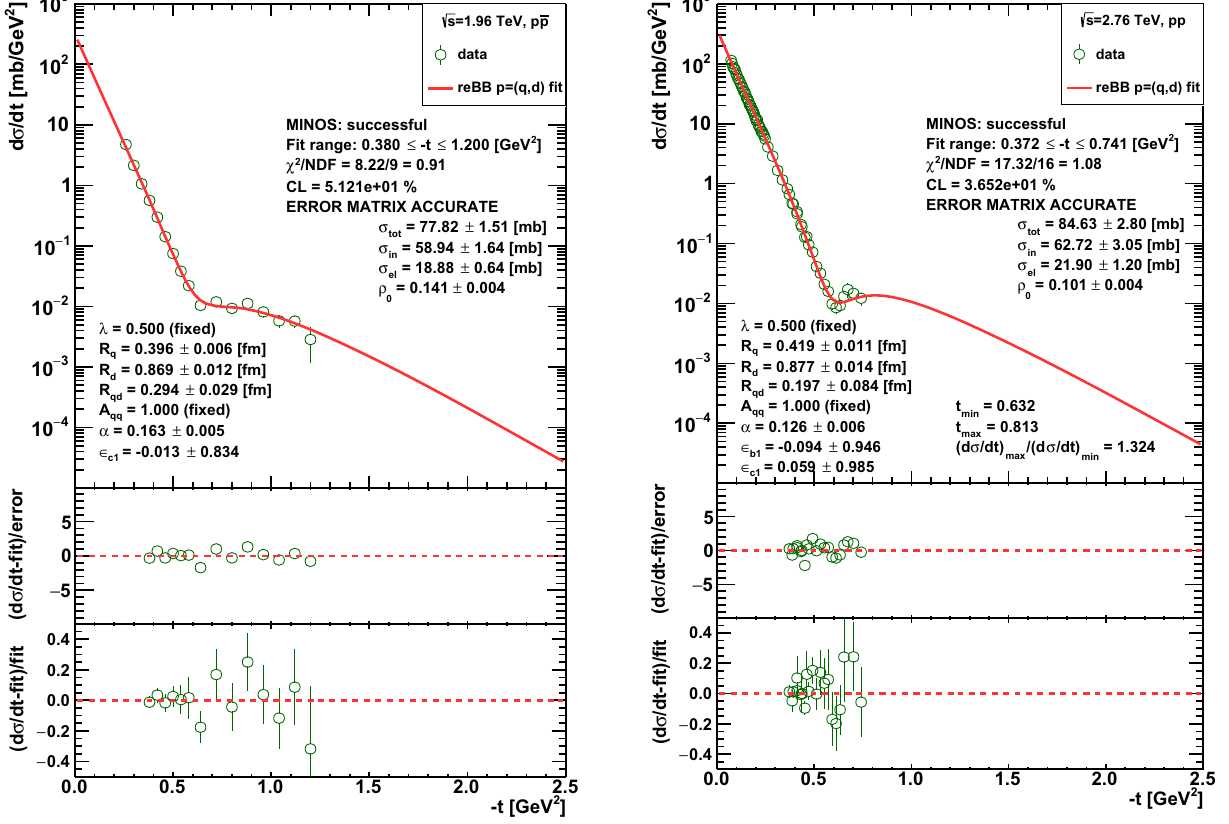
√ √ Fig. 3 The fit of the ReBB model to the pp TOTEM s = 2 . 76 TeV Fig. 2 The fit of the ReBB model to the p ¯ p D0 s = 1 . 96 TeV data in the range of 0 . 37 ≤ − t ≤ 0 . 74 GeV 2 [9]. The fit includes the data [45] in the range of 0 . 37 ≤ − t ≤ 1 . 2 GeV 2 . The fit includes t -dependent statistical (type A) and systematic (type B) uncertainties, the t -dependent statistical and systematic uncertainties added together the normalization (type C) uncertainty and the experimental value of quadratically and treated as type A errors as well as the normalization the total cross section with its full error according to Eq. (6). Otherwise, (type C) uncertainty according to Eq. (6). The values of the total cross same as Fig. 1 section and parameter ρ 0 used in the fit are the predicted values from the COMPETE Collaboration [51]. Otherwise, same as Fig. 1 The elastic p ¯ p differential cross section data is available √ s = 1 . 96 TeV in the range of 0 . 26 ≤ | t | ≤ 1 . 20 GeV 2 , at as published by the D0 Collaboration in Ref. [45], with a type C normalization uncertainty of σ c = 0 . 144. For this data set, the vertical type A and type B errors were not published separately. Actually, the quadratically added statistical and systematic uncertainties were published, and as the statisti- cal errors are point to-point fluctuating, type A errors, in our analysis the combined t dependent D0 errors were handled as type A, combined statistical and systematic errors.